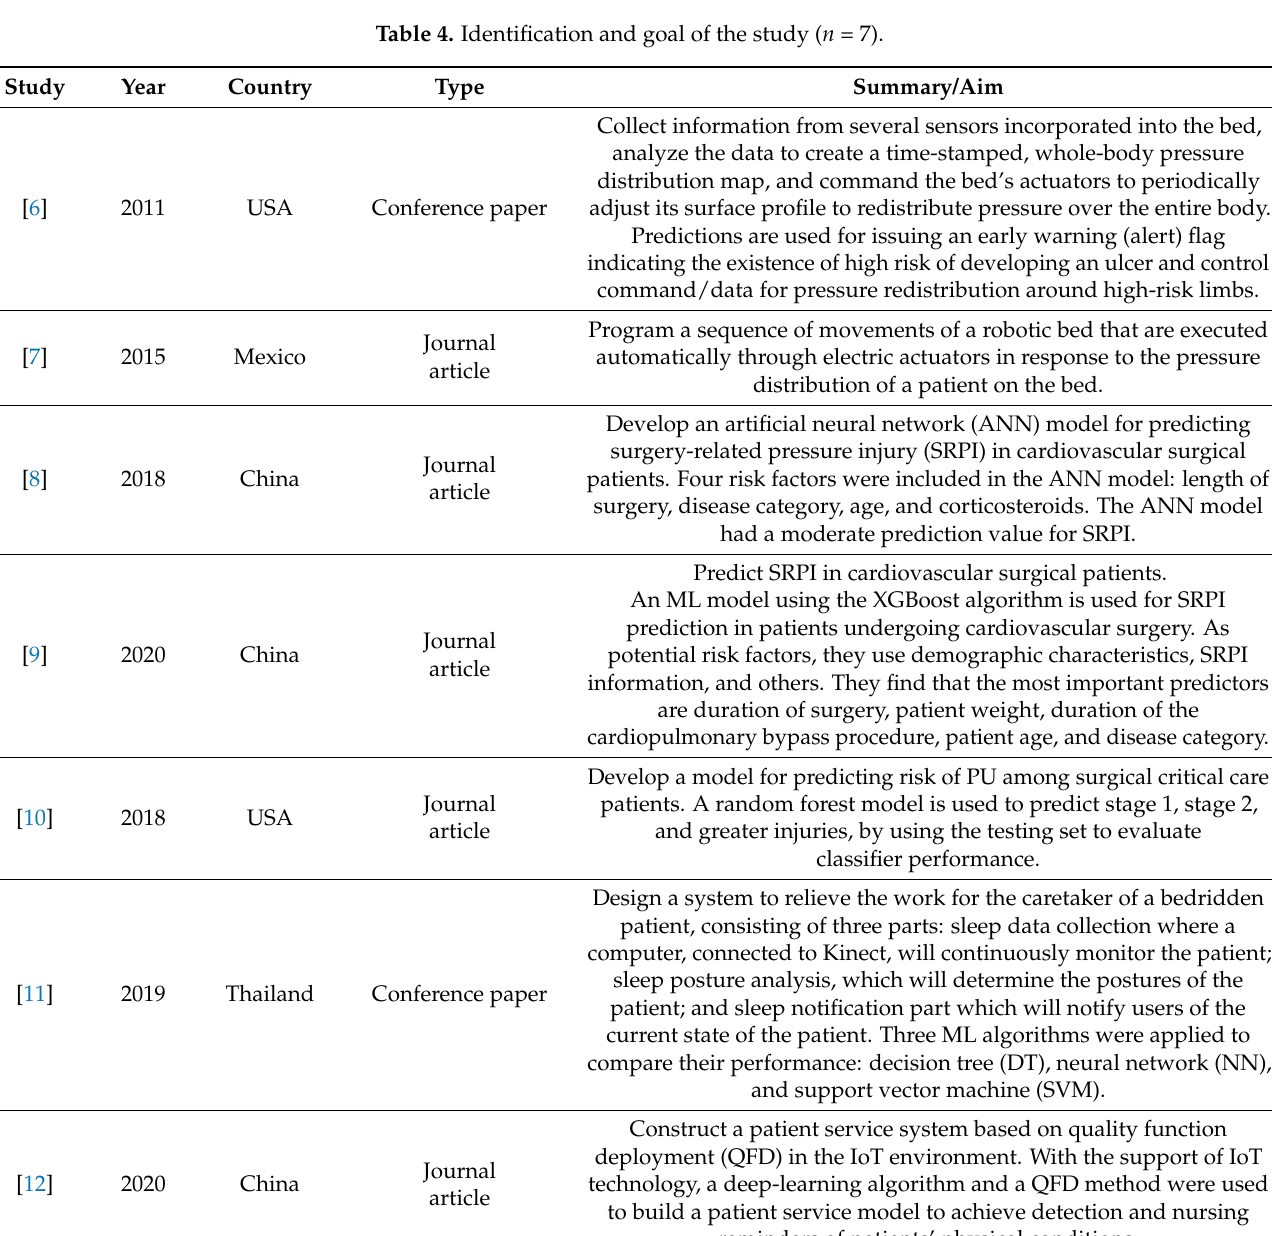
Table 4. Identification and goal of the study ( n =